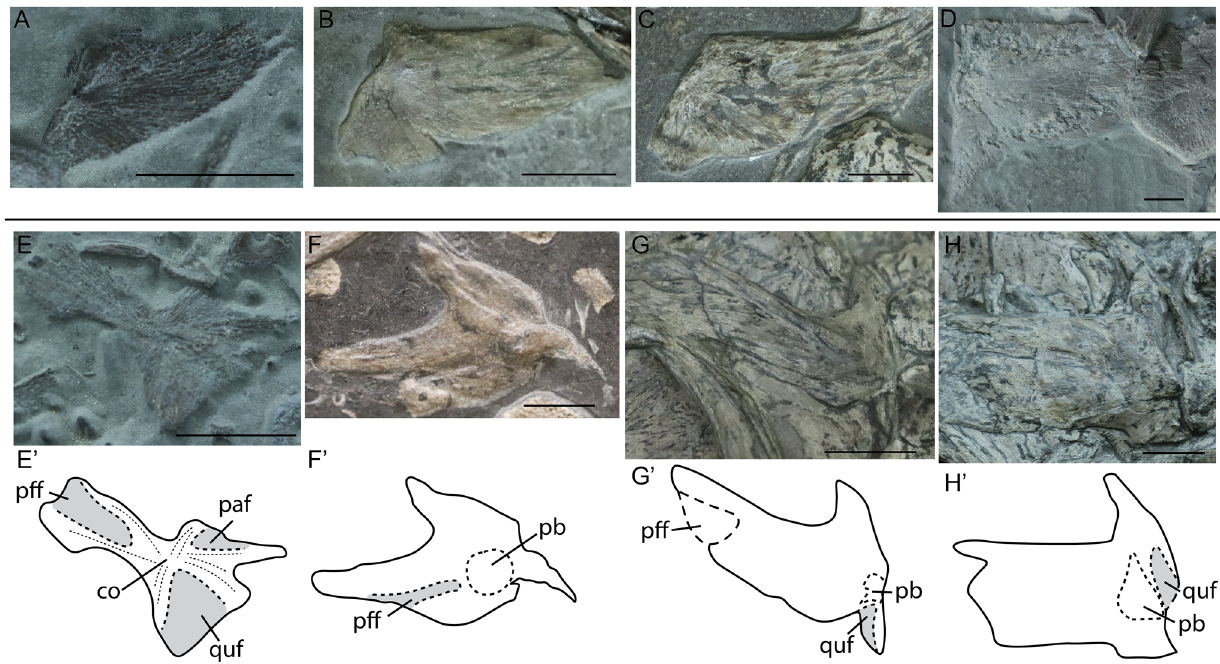
Figure 3. Squamosals in medial? ( A ) and lateral ( B – D ) views and supratemporals in posterodorsal ( E – H ) view of selected specimens of Stenopterygius . Interpretative drawings denoted by an apostrophe with their corresponding letter. ( A ) stage 3 embryo S. quadriscissus SMNS 80234; ( B ) postnatal 1 S. quadriscissus SMNS 51139; ( C ) postnatal 2 S. quadriscissus SMNS 50003; ( D ) sexually mature S. quadriscissus SMNS 81961; ( E ) stage 3 embryo S. quadriscissus SMNS 80234; ( F ) stage 4 embryo S. quadriscissus SMNS 54062; ( G ) postnatal 1 S. quadriscissus SMNS 82046; ( H ) sexually mature S. quadriscissus SMNS 51554. co centre of ossification, paf parietal facet, pb posterior bulge, pff postfrontal facet, quf quadrate facet. Scale bar: ( A–H ) = 10 Cheek area. Quadratojugal. The quadratojugal has distinct lateral facets for articulation with the postorbital and the squamosal, and is often obscured in articulated specimens. On the medial surface, a socket-like articular